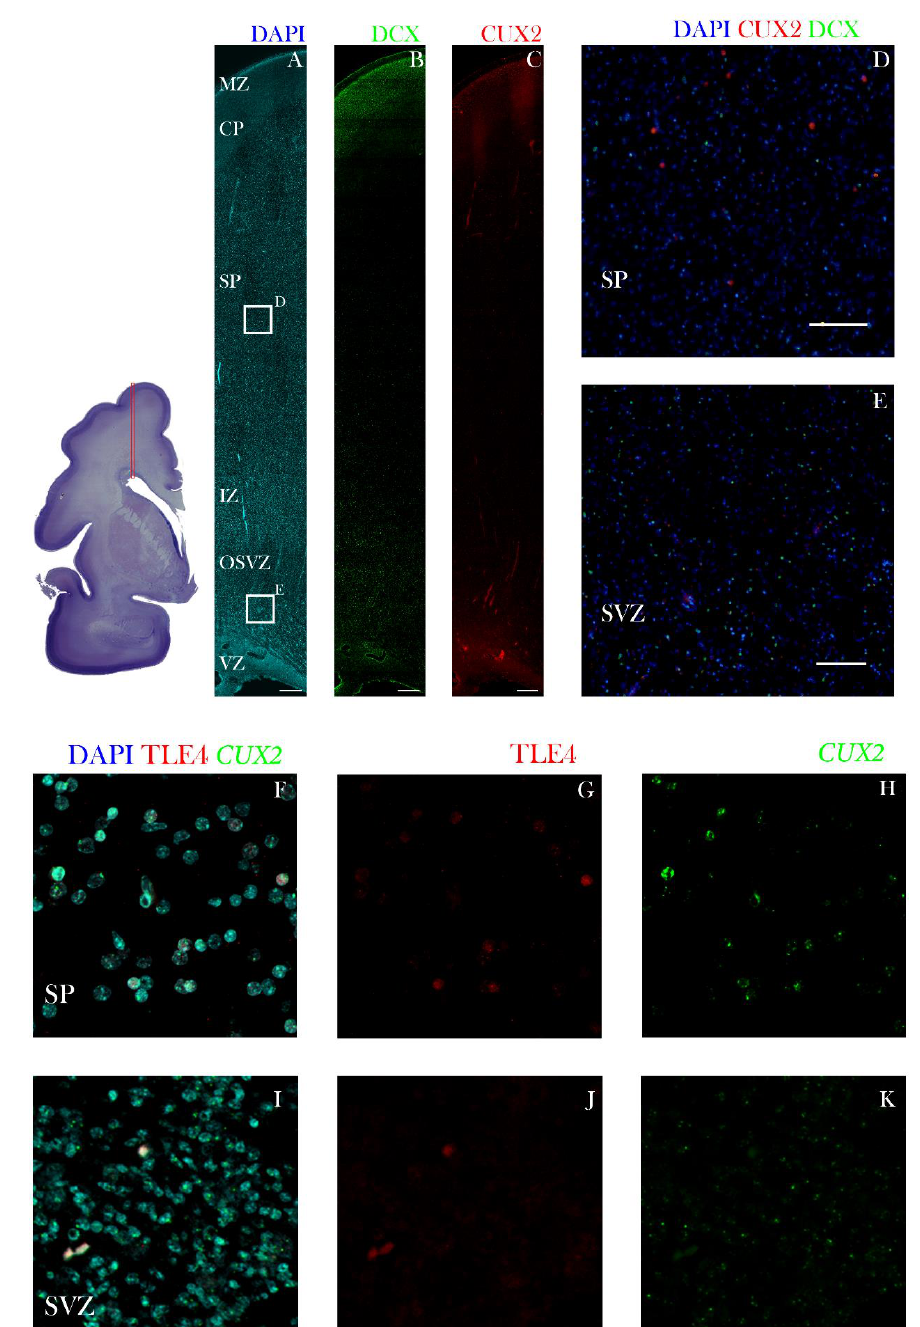
Figure 8. CUX2 is expressed in MZ, CP and SP during the peak of SP at 26 PCW. Top left shows complete scan of frontal coronal section stained for Nissl. Red box denotes place of representative confocal images shown in A–C. ( A–E ) Cerebral wall of the superior frontal gyrus at 26 PCW stained for CUX2 (red), marker of immature migratory neurons DCX (green), and DAPI (blue). D is higher magnification of superficial box denoted in A. E is higher magnification of lower box denoted in A. CUX2+ nuclei were found in MZ, upper part of CP and scattered along the SP ( A–D ). The large CUX2+ nuclei in the SP mostly do not co-localize with DCX neurons ( D ). Somewhat weaker CUX2+ protein expression was detected in the OSVZ ( E ). ( F–K ) Cerebral wall of the superior frontal gyrus at 26 PCW stained marker of deep layer neurons TLE4 (red) and DAPI (blue). Immunostaining was coupled to the fluorescent RNAScope ® to detect CUX2 mRNA (green). CUX2 mRNA is expressed in the SP and SVZ, respectively. We did not detect co-localization of CUX2 mRNA and TLE4 in the SP, while CUX2 mRNA expression was detected in the SVZ, paralleling the protein expression. Scale bars: A, B, C = 500 µ m; D, E = 100 µ m; F–K = 50 µ